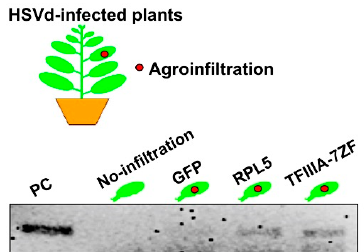
Figure 3. RNA-immunoprecipitation supporting that TFIIIA-7ZF and RPL5 bind to HSVd in vivo. HA-tagged proteins (GFP, RPL5, and TFIIIA-7ZF) were expressed in HSVd-infected N. benthamiana plants via agroinfiltration and served as baits. RPL5 and TFIIIA-7ZF as baits successfully pulled down HSVd RNA. No-infiltrated and GFP-expressing leaves served as negative controls. The experimental methods were described previously [21]. PC, monomeric HSVd cDNA served as a size marker.